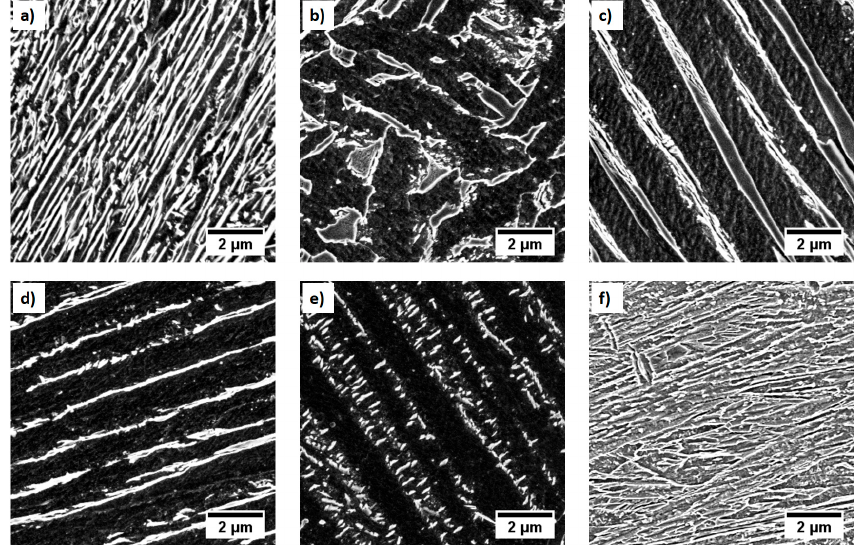
Figure 6. Representative scanning electron microscope (SEM) images of the six microstructure classes found in the samples, after cropping to 350 × 350 px (equal to 9.70 × 9.70 µ m): ( a ) pearlite, ( b ) granular bainite, ( c ) degenerated upper bainite, ( d ) upper bainite, ( e ) lower bainite, and ( f ) martensite. Etching was done using 2% Nital.